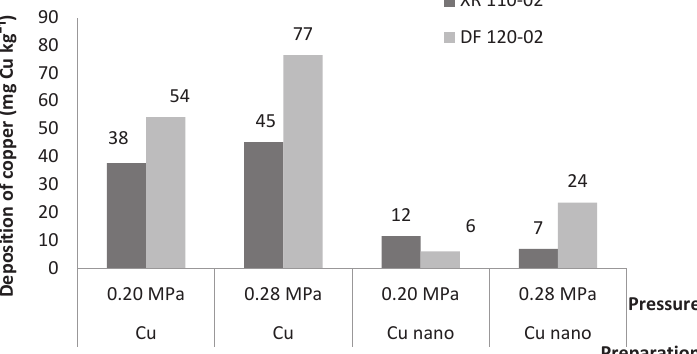
Fig.2. The deposit of copper on the rape plants at the development phase of 4 leaves (14 BBCH) for the studied nozzles (flat fan XR 110-02 and double flat fan DF 120-02) at the pressure of 0.20 and 0.28 MPa. Cu – fertilizer was Mikrovit Copper 80, and Cu nano – contained nano